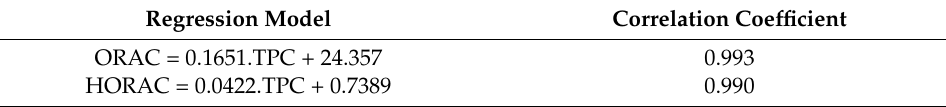
Table 6. Correlation between total phenolic content and antioxidant activity. Regression Model Correlation